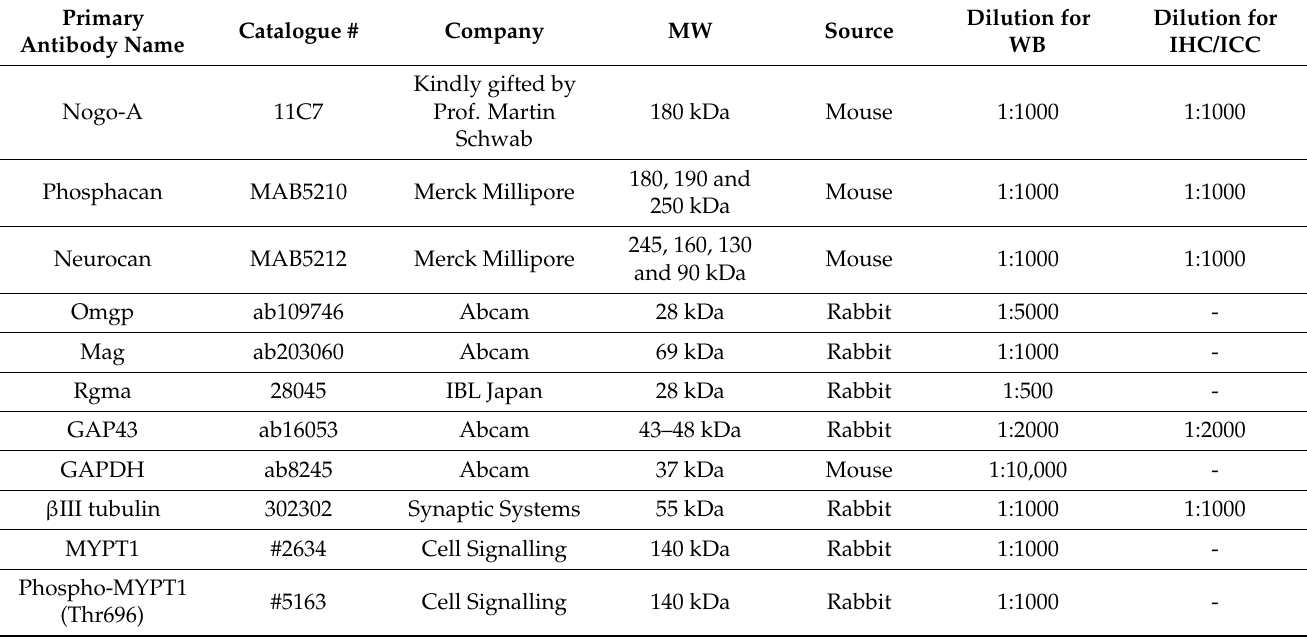
Table 1. Primary antibodies used in Western Blotting, Immunohistochemistry and Immunocitochem- istry